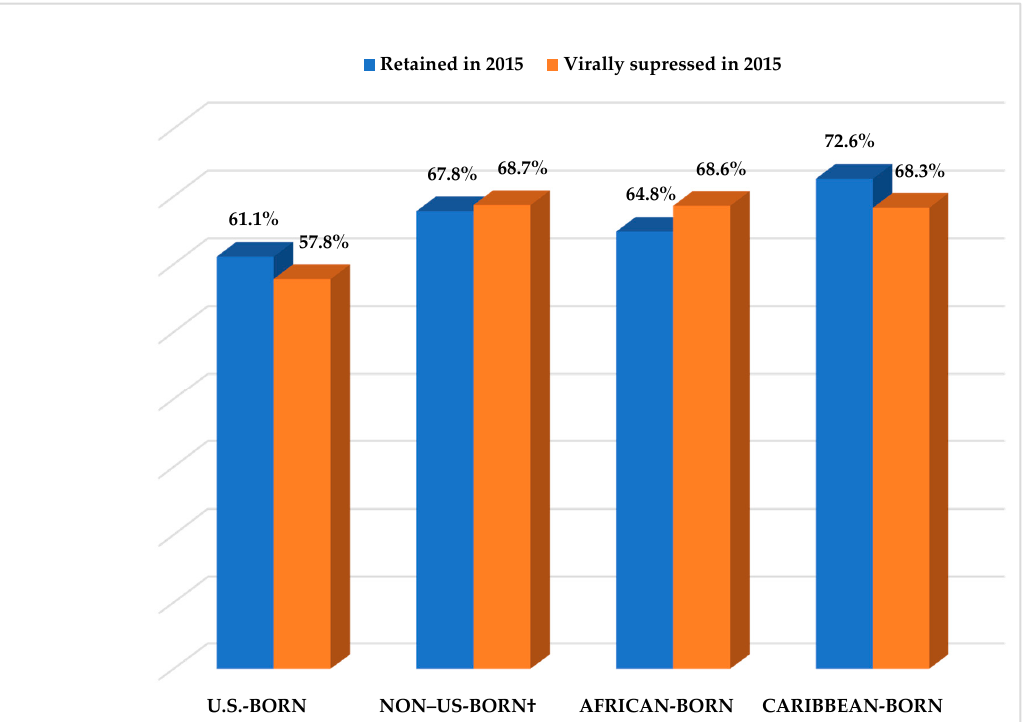
Figure 2. Retention and viral suppression during 2015 among blacks aged ≥ 13 years with HIV infection diagnosed during 2014 and who were alive as of December 31, 2015, by place of birth, National HIV Surveillance System, 40 U.S. areas. † Includes African- and Caribbean-born blacks. The percentages of non-U.S.-born blacks who had achieved viral suppression were higher than the percentages retained in care for the majority of the selected demographic characteristics, except those aged 13–24 years and ≥ 55 years and females with HIV transmission categorized as “other.” In contrast, among U.S.-born blacks, the percentage who had achieved viral suppression was consistently lower than the percentage retained in care across all demographic